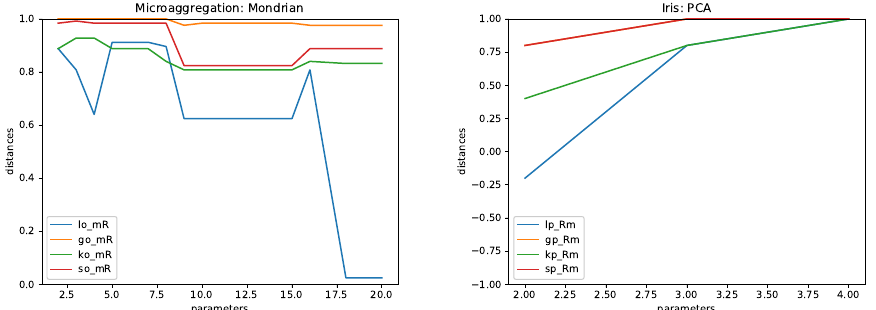
Figure 6. Rank correlation of mean Shapley values (_Rm) for Microaggregation (Mondrian) and PCA. The four types of machine learning models considered are linear regression (letter l), SGD Regressor (letter g), Kernel Ridge (letter k), and SVM (letter s). Computations for the diabetes